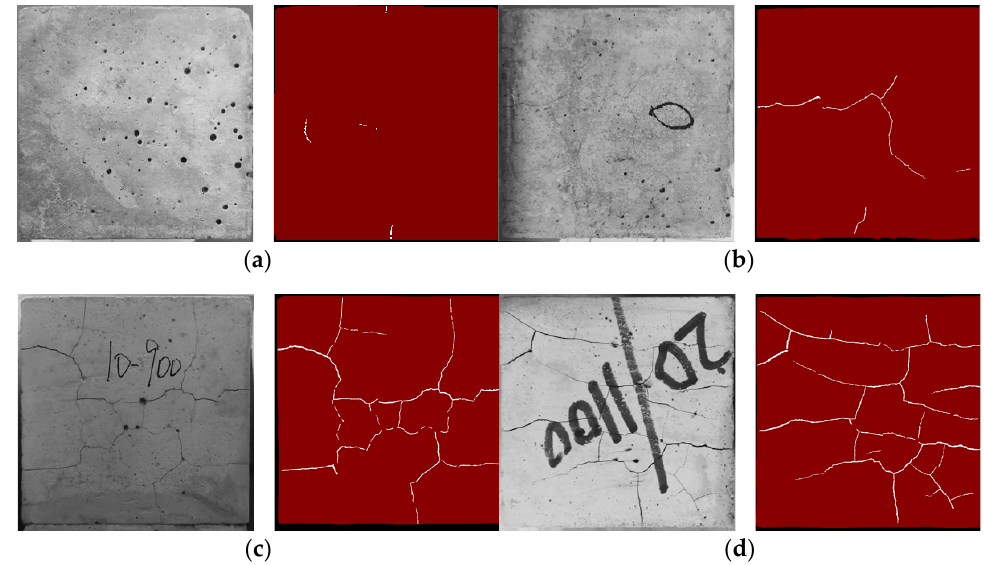
Figure 2. Data annotation (( a – d ) are the four samples in the image dataset; left is original image; right is annotation result).